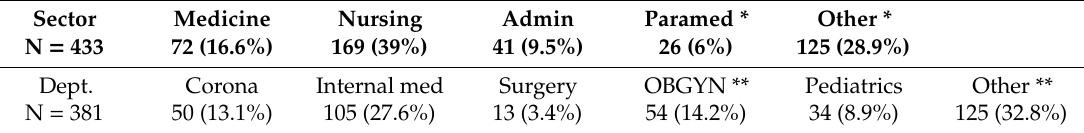
Table 1. Distribution of the interviewees according to sector and